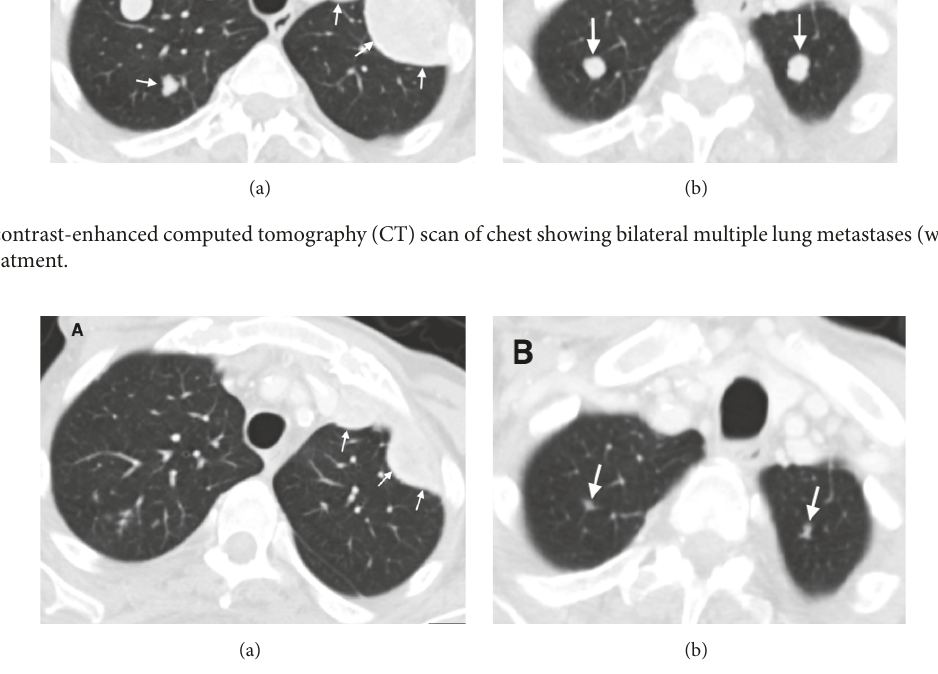
Figure 2: Axial contrast-enhanced corresponding CT scan images after 12 weeks of nivolumab treatment showing a partial response with reduction in size of multiple bilateral lung metastases (white